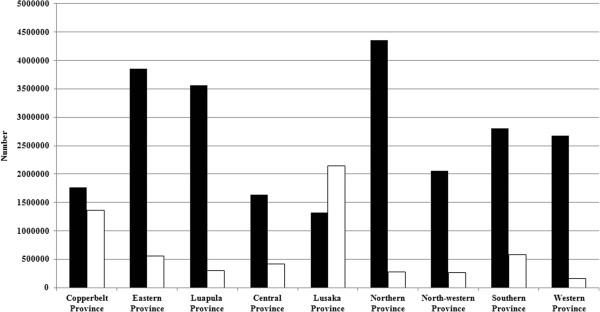
Distribution of IRS and LLIN by province, 2006 to 2011. (Black bars indicate LLINs, open bars indicate IRS).